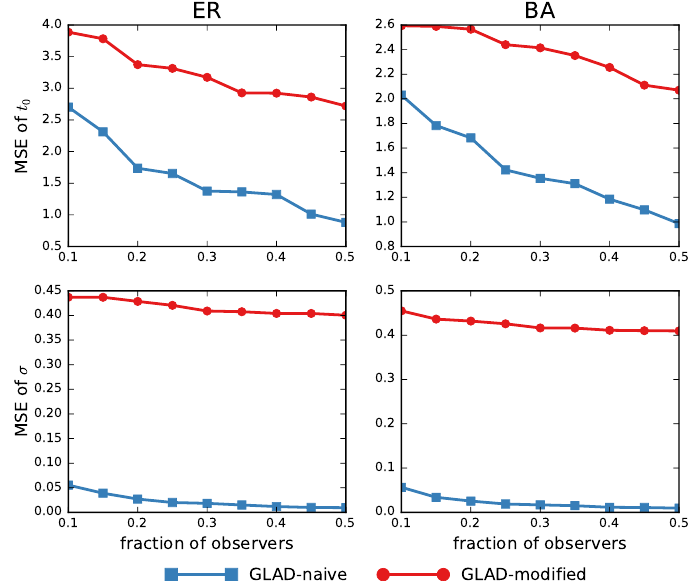
Figure 5. MSE of the diffusion parameters in synthetic trees. In the diffusion process, the initial time t 0 = 0 and the diffusion delay along edges i.i.d follow N ( 4,1 ) . Note that the MSE results of t 0 and σ are not calculated based on estimated source, but rather on the real